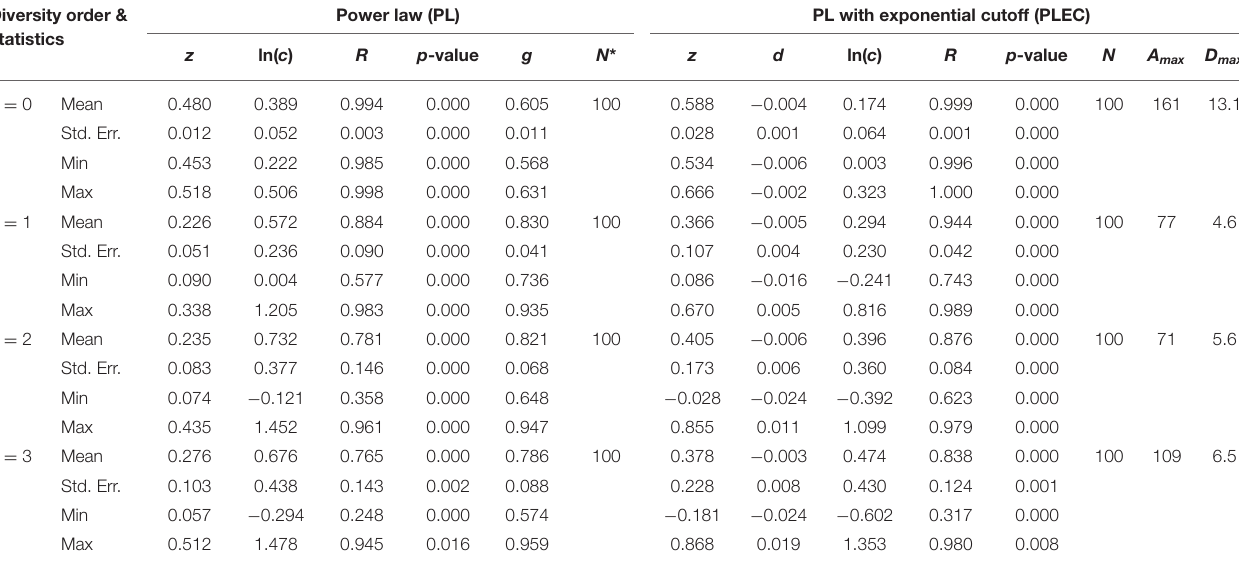
TABLE 4 | The parameters of beta -DAR ( beta -diversity area relationship) computed with 100 times of re-sampling at species level. Diversity order & statistics